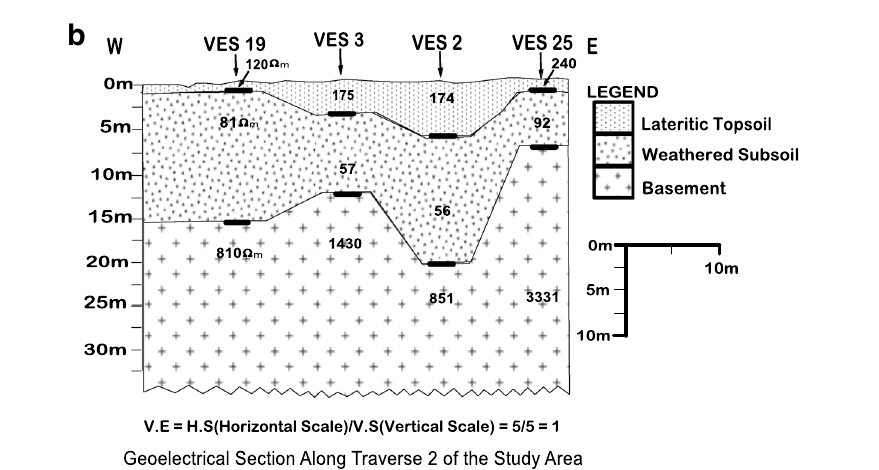
Fig. 6 Geoelectric sections along traverse 1 and